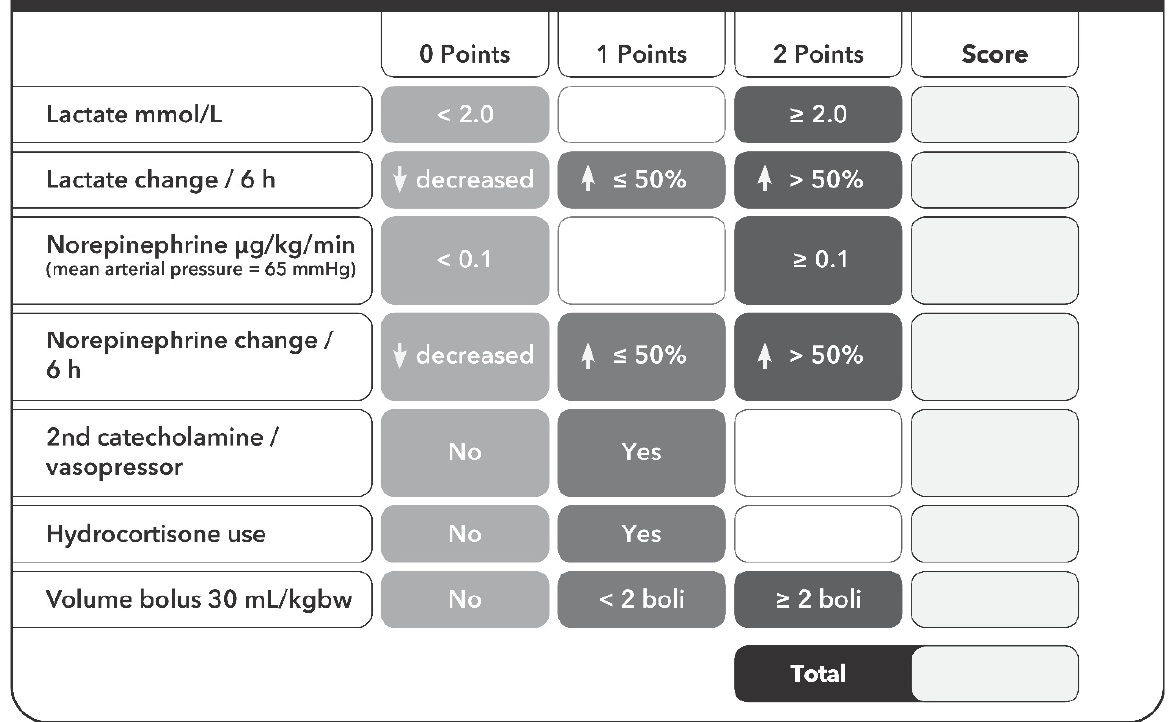
Figure 1. Dynamic Scoring System. Each parameter at the time of septic shock diagnosis (T 0h ) and 6 h (T 6h ) later is documented to analyze the dynamic process in early septic shock. Each pathological value is rated with 2 points. Decreasing values or no change during the 6 h observation period receives no points, increasing values receive 1 point, increasing values >50% of the initial value receive 2 points. If <2 volume boluses of 30 mL/kg are necessary, this is rated with 1 point, when ≥ 2 volume boluses of 30 mL/kg are necessary within 6 h, this is scored with 2 points.